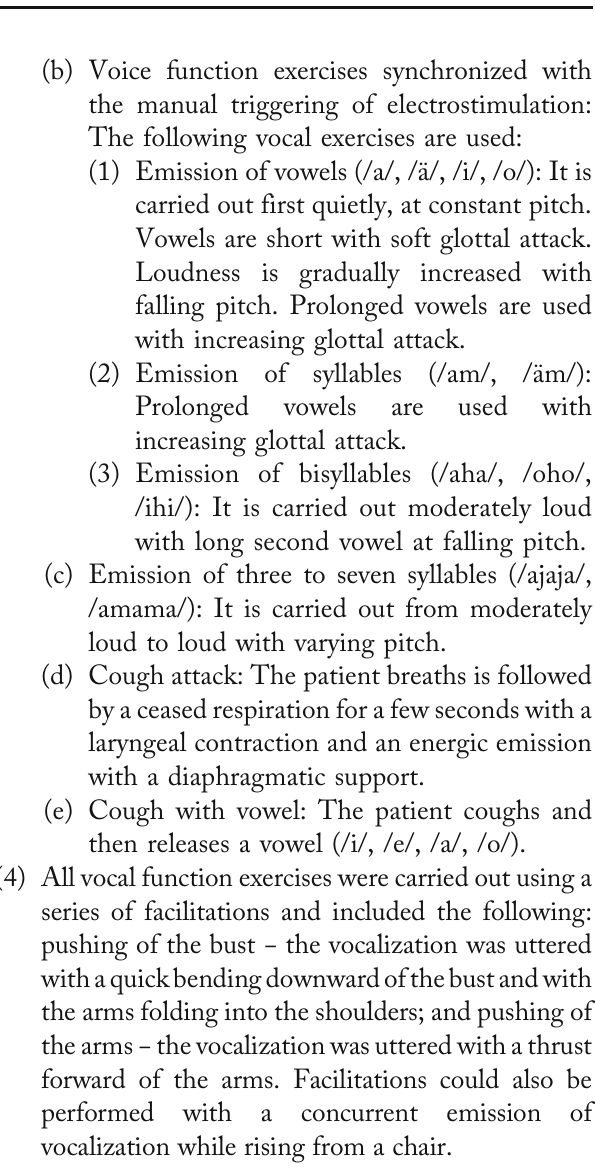
The placement of the electrodes in submental